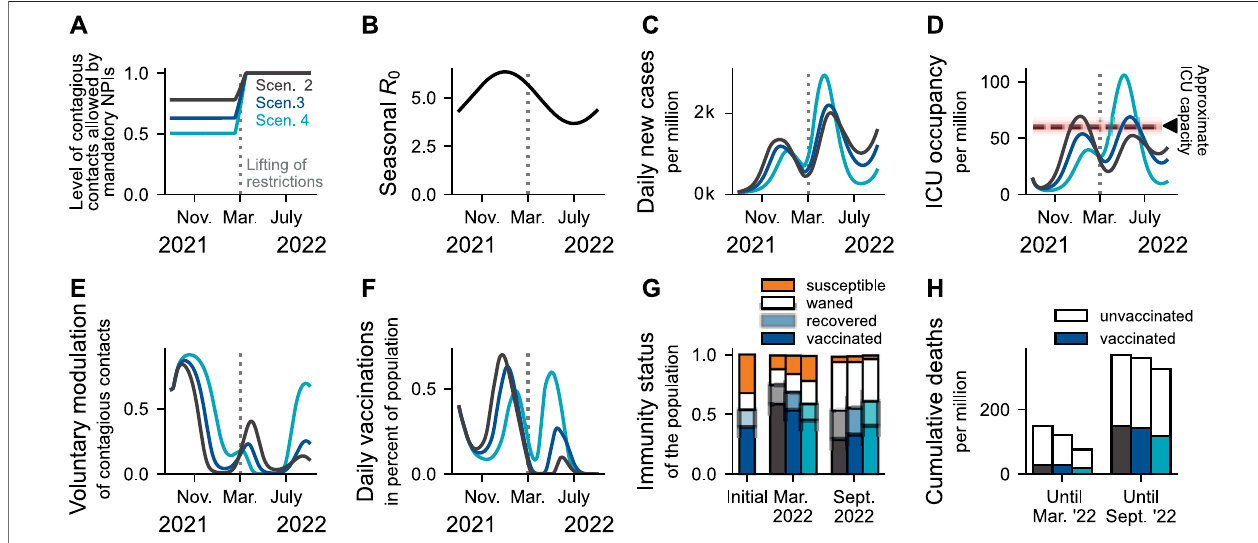
FIGURE 5 | Moderate restrictions leave enough room for effective adaptation of behavior to perceived risk. (A) : We explore three scenarios with similar levels of moderate mandatory NPIs sustained throughout winter, the period of adverse seasonality (B) . Considering Scenario 3 as reference, moderate restrictions seem to be robust against relaxations of NPIs, as both morbidity and mortality are similar to that of Scenario 2 (C,D,H) . However, a perturbation with less strength in the opposite direction (Scenario 4, increasing mandatory NPIs) has a disproportional effect on ICU occupancy. These differences are based on the modulation of voluntary contacts (E) and vaccine uptake (F) . Thus, when leaving room for adaption of health-protective measures to perceived risk, people ’ s behavior will stabilize moderate scenarioswheremandatoryNPIsarestrongenough topreventamajorsurge,butnotover-protective,soindividuals fi nditrewardingtobevaccinated andtoadapttheir level of contacts. Note that disproportionally more vaccinated individuals die after March 2022 because, at this point, most of the population is vaccinated (G) .